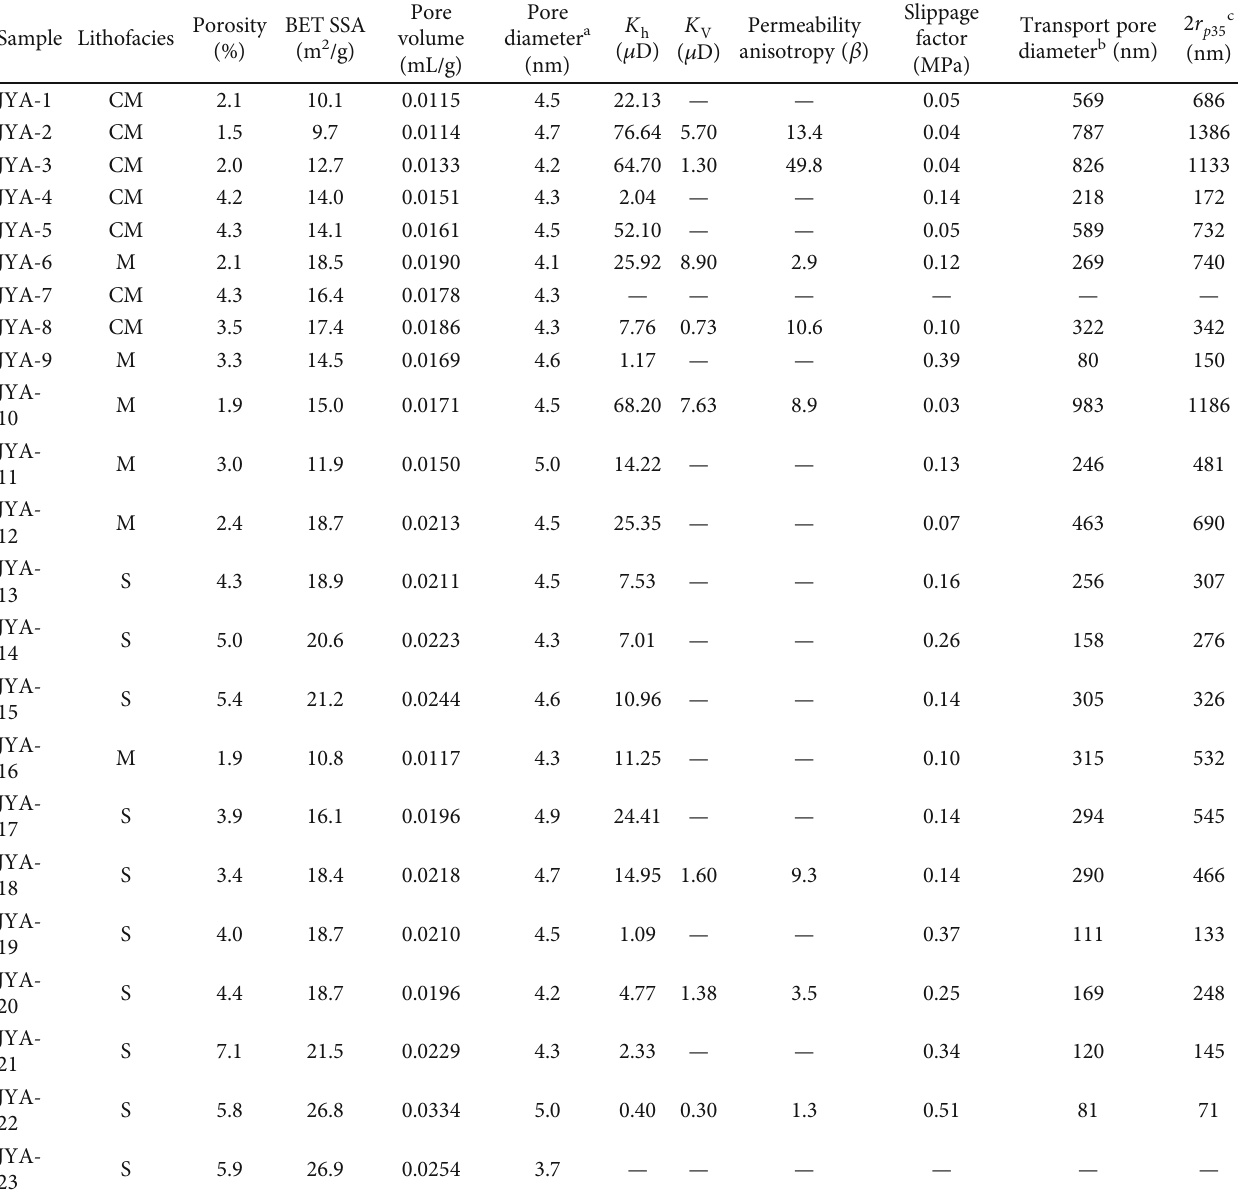
Table 2: Pore structure, porosity, permeability, and permeability anisotropy ( β ) of the shale samples. Porosity Sample Lithofacies